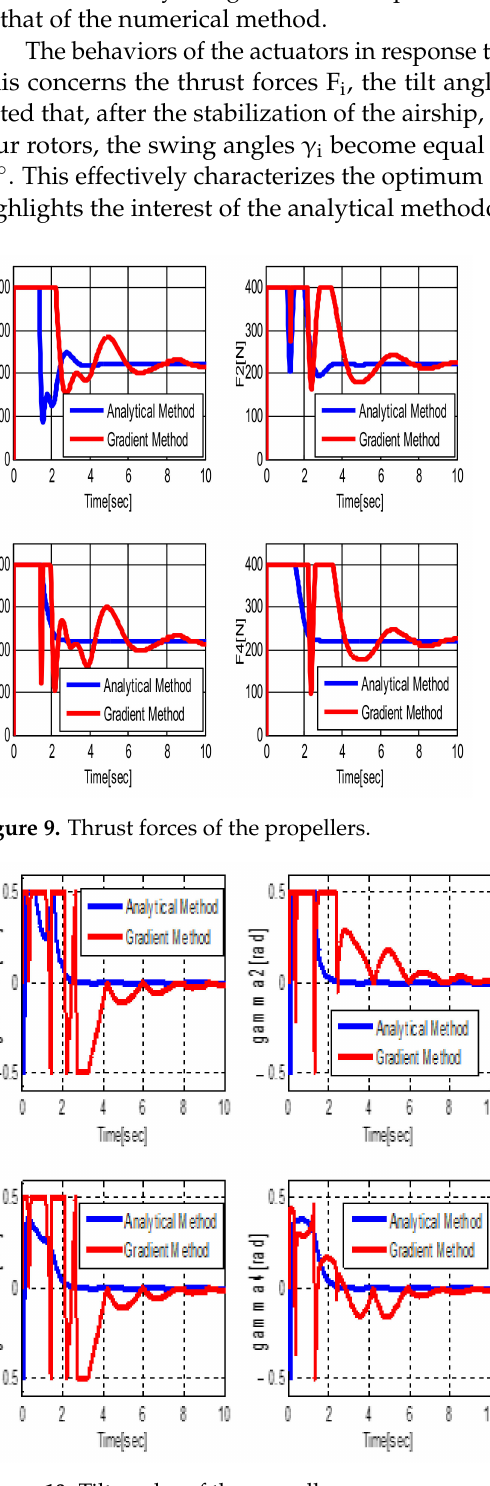
Figure 10. Tilt angles of the